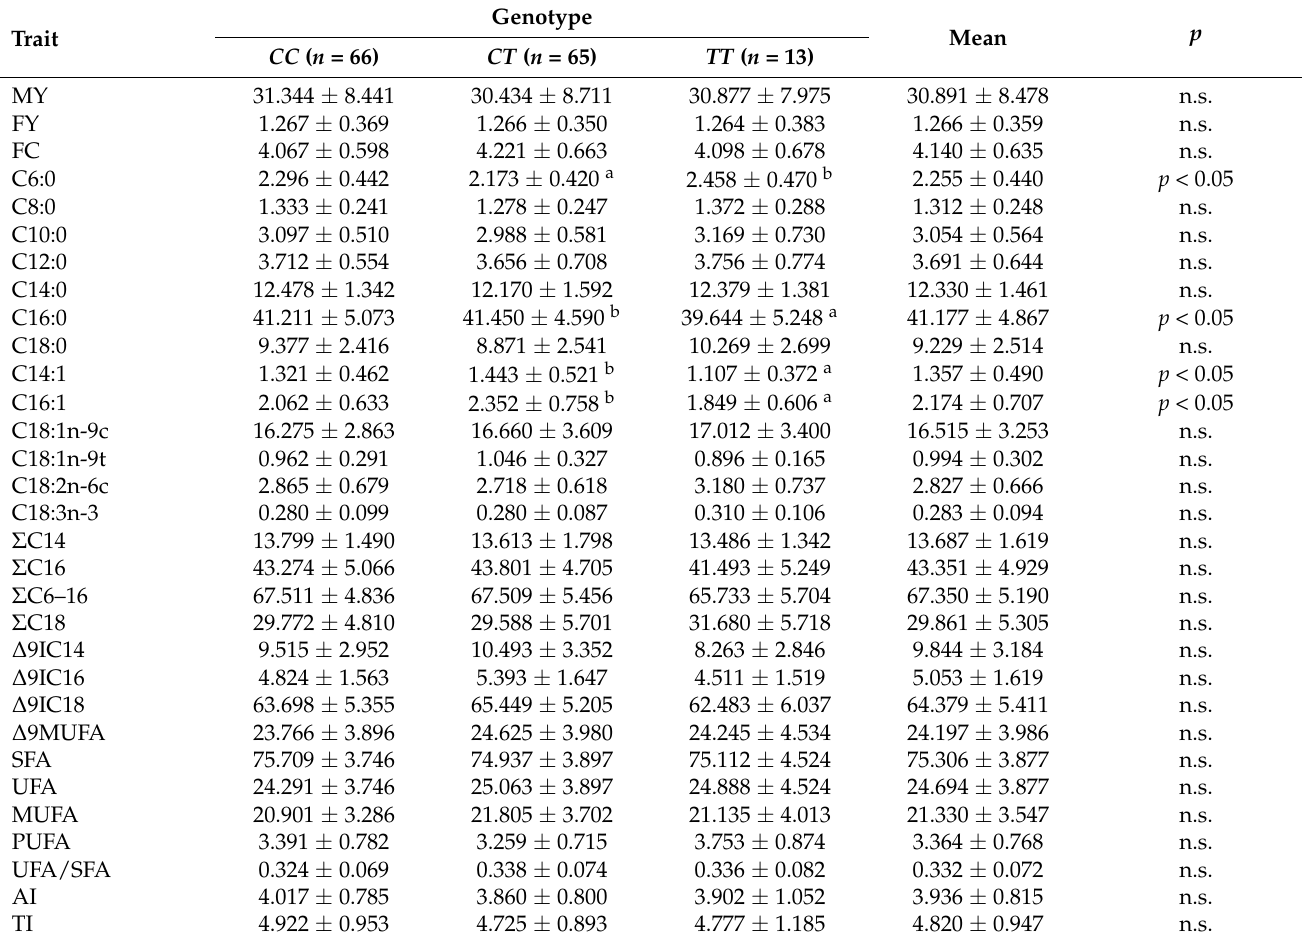
Table 4. Association of THRSP genotypes with analyzed traits of milk in Polish Holstein-Friesian cows. Trait